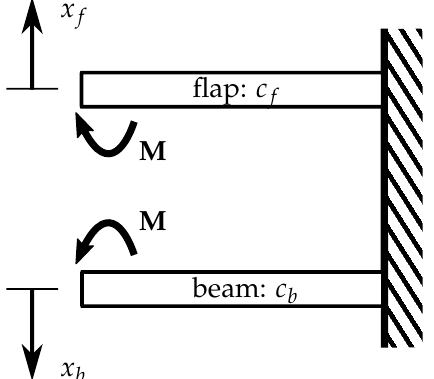
Figure 8. Model to determine the minimum stiffness of the flap